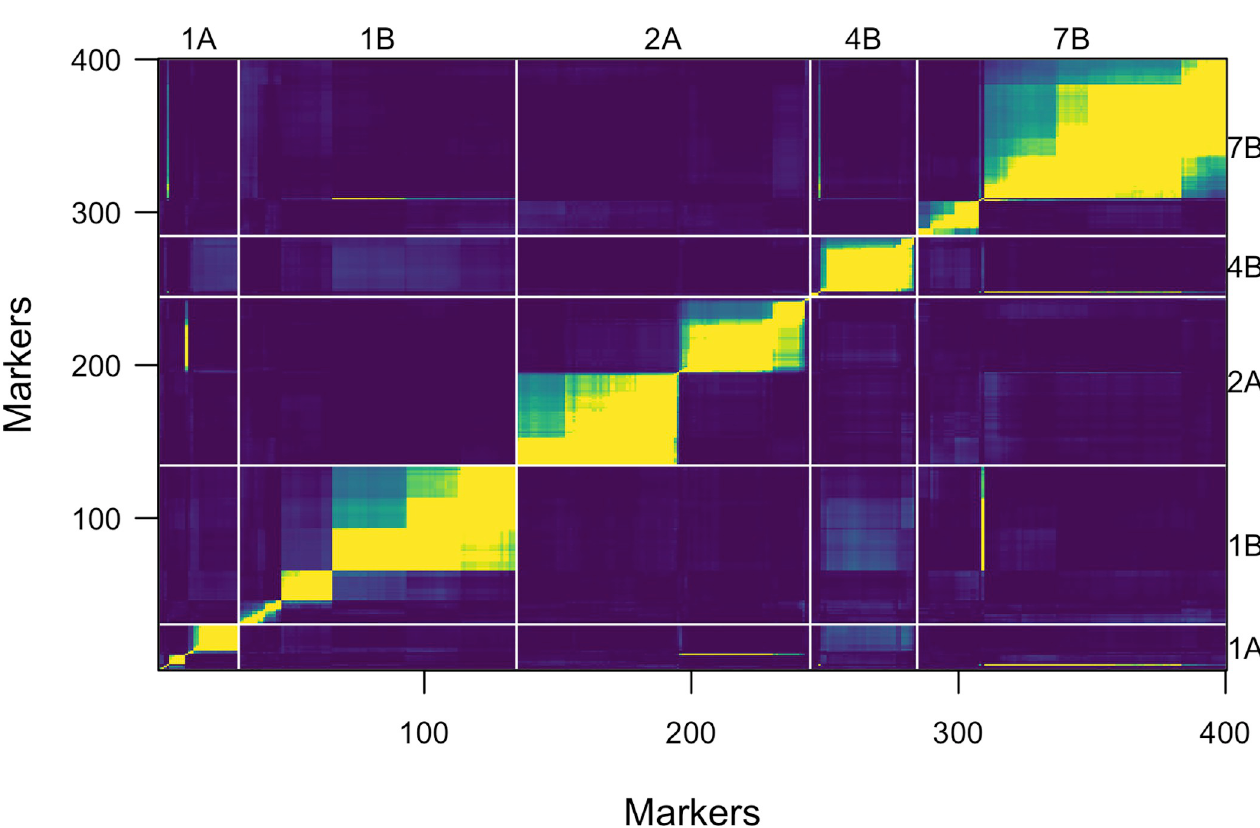
Fig 3. Heatmap of recombination fraction (upper left triangle) and LOD score (lower right triangle) of selected chromosomal regions with misaligned markers indicated by yellow strip on the blue background.